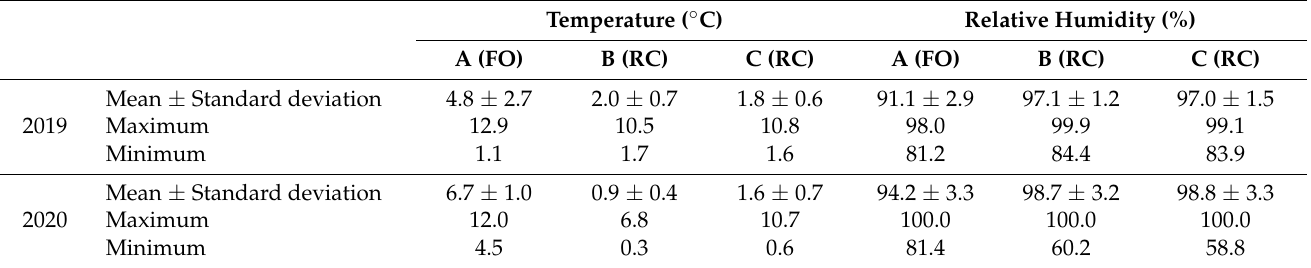
Table 2. Temperature and relative humidity values in the three chambers of the sweet cherry cv. Satin conservation study. Chamber A was located in FO with treatment 1. Chambers B and C were located in RC with treatments 2 (NA), 3 (3%O 2 –10%CO 2 ), 4 (3%O 2 –15%CO 2 ), 5 (10%O 2 –10%CO 2 ) and 6 (10%O 2 –15%CO 2